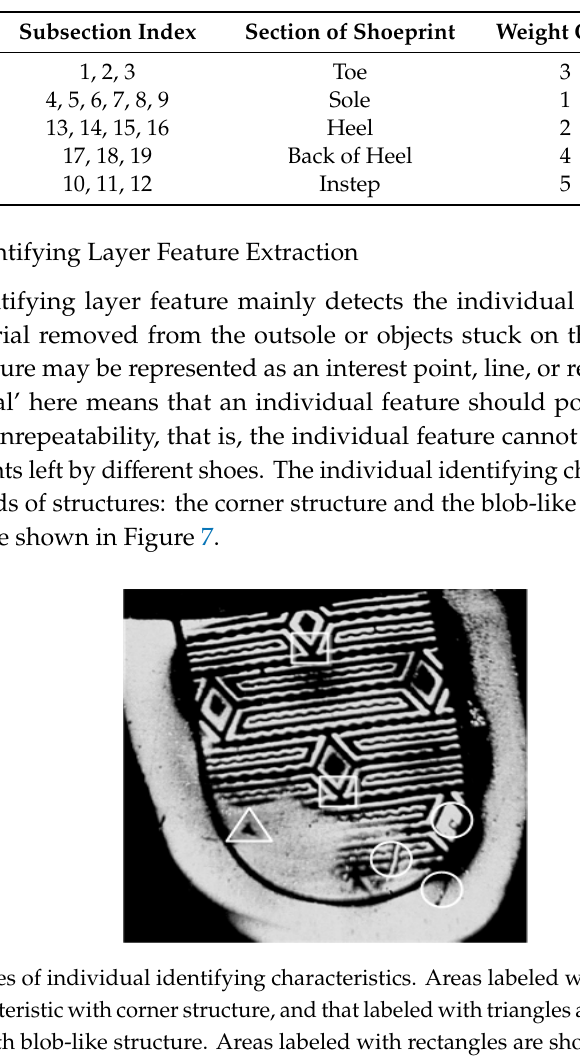
Table 1. Weight order of each subsection in a shoeprint.